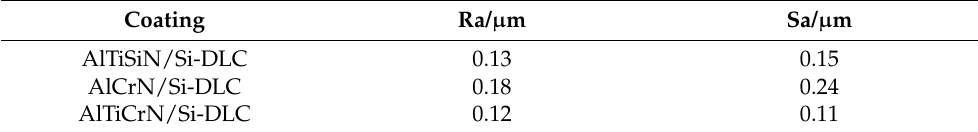
Table 2. Roughness values of Si-DLC coatings with different transition